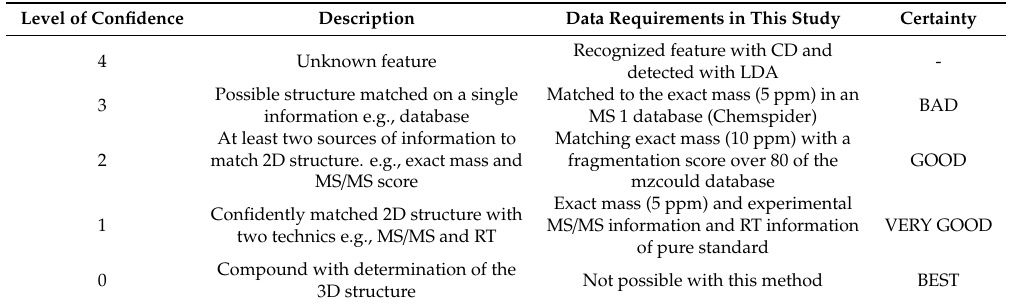
Table 1. Requirements as promoted by the Metabolomics Society [14,36] and their implementation into this